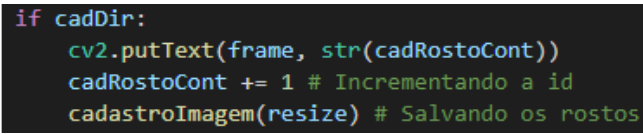
Figure 13: Decision Command for Registering